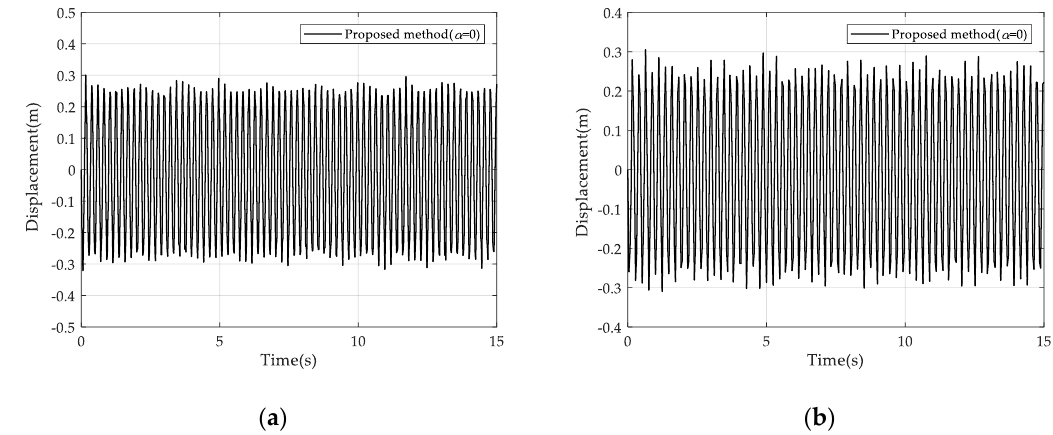
Figure 14. Vertical displacement responses of Point A with ∆ t = 0.02 s and ∆ t = 0.04 s: ( a ) Displacement response with ∆ t = 0.02 s. ( b ) Displacement response with ∆ t = 0.04 s.